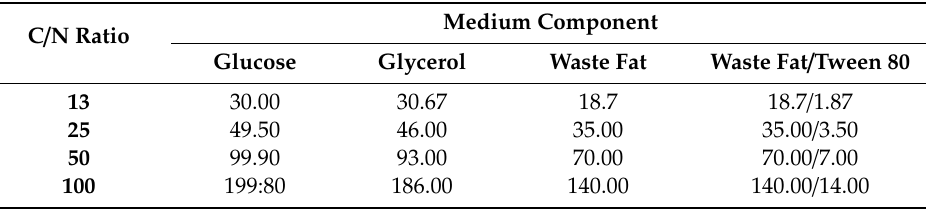
Table 1. Composition of production media with di ff erent C / N ratios. C / N